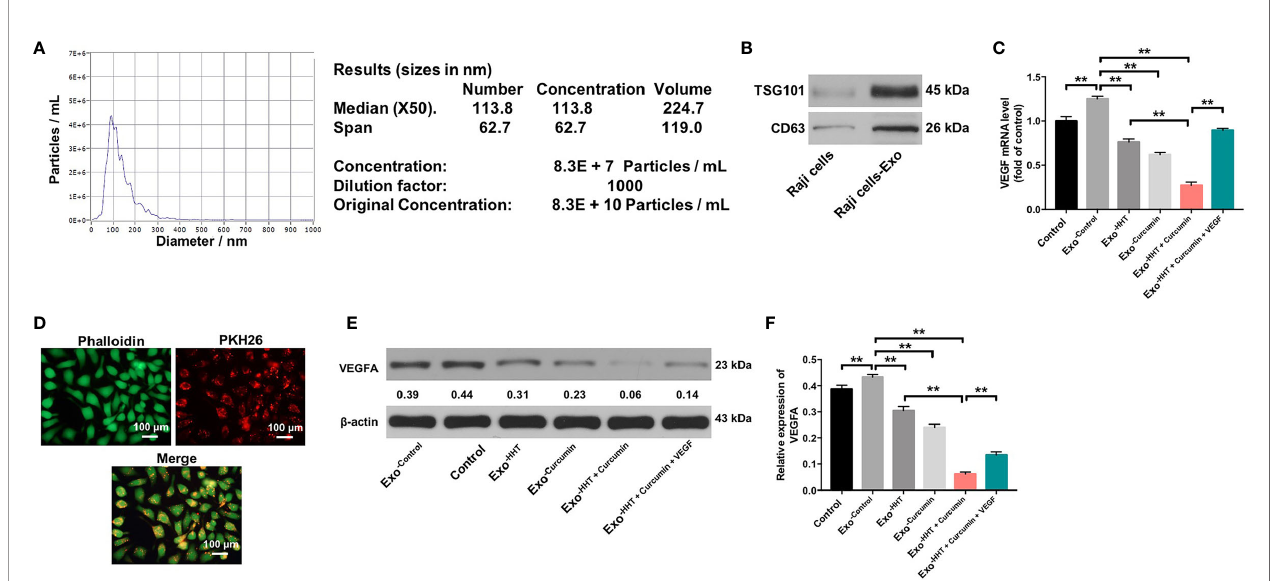
FIGURE 4 | Lymphomas exosomes are absorbed by HUVECs. (A) The mean diameter of lymphomas exosomes was analyzed using the NTA. (B) Western blot analysis of the exosome marker TSG101 and CD63 in Raji cells and the exosomes isolated from Raji cells. (C) RT-qPCR analysis shows VEGF levels in exosomes obtained from Raji cells that were treated with HHT or/and curcumin or treated with HHT, curcumin and VEGF. (D) Confocal microscopy image shows presence of PKH26 dye (Red) in HUVECs after adding PKH26-labeled exosomes derived from Raji cells. Phalloidin (green) was used to stain F-actin. (E, F) HUVECs were co- cultured with exosomes obtained from Raji cells that were treated with HHT or/and curcumin or treated with HHT, curcumin and VEGF. Expression level of VEGFA in HUVECs were detected with western blotting. **P <